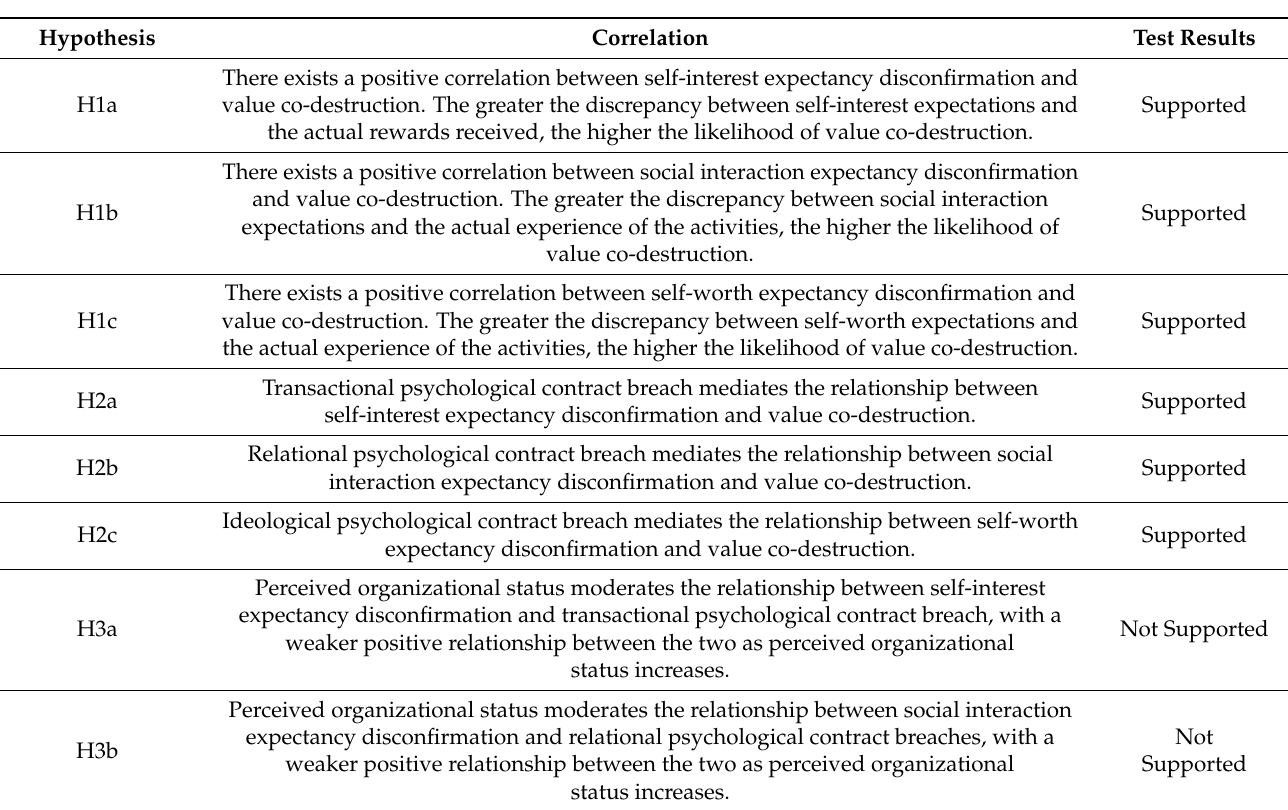
Table 10. Results of path coefficients and hypotheses testing.